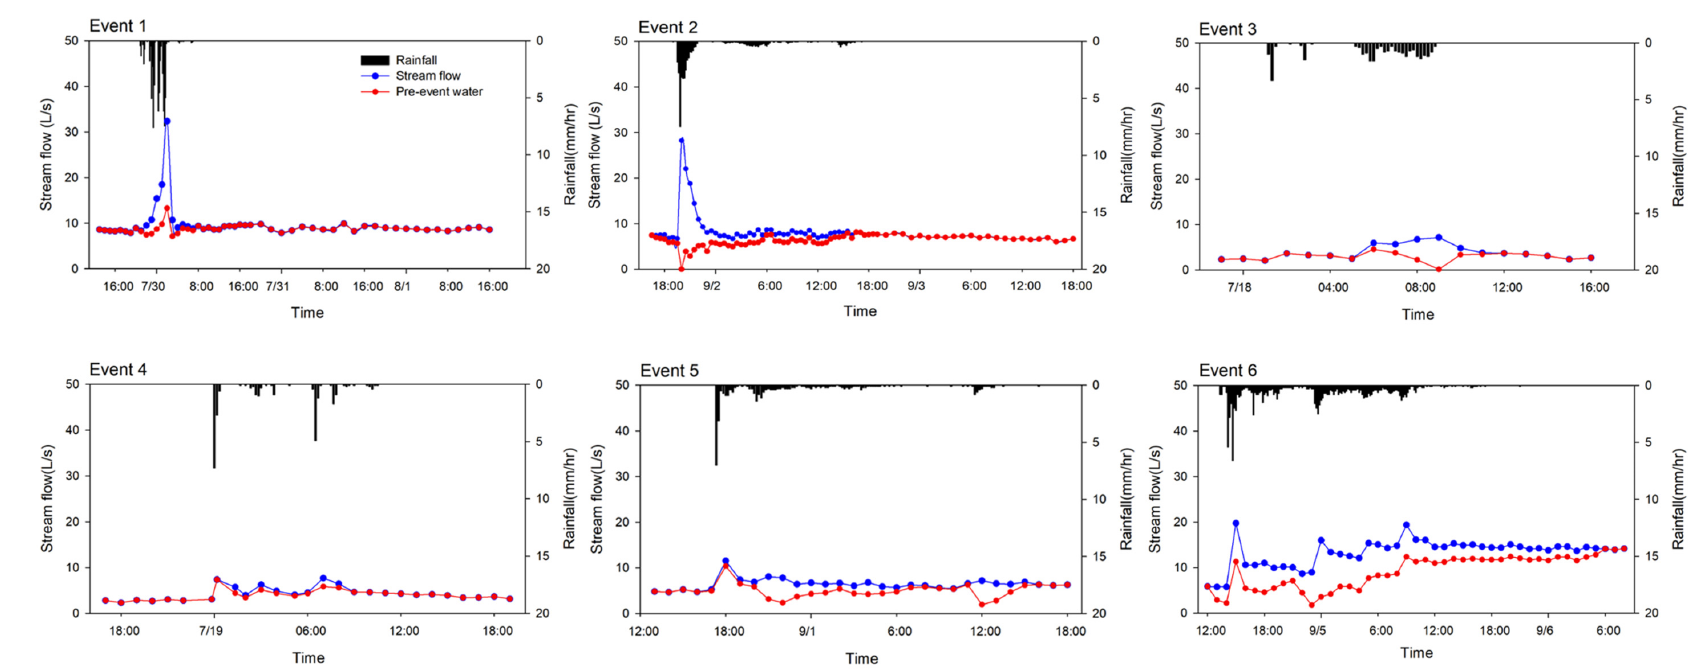
Figure 7. The hydrograph separation between event and pre-event runoff for 6 events using one-tracer two component analysis with δ 2 H.